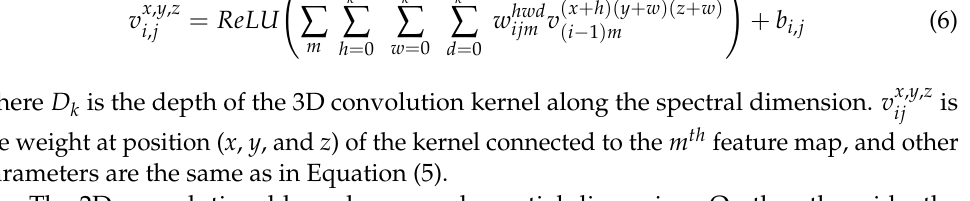
= K 5 = 3). Where 64 is the 2 1